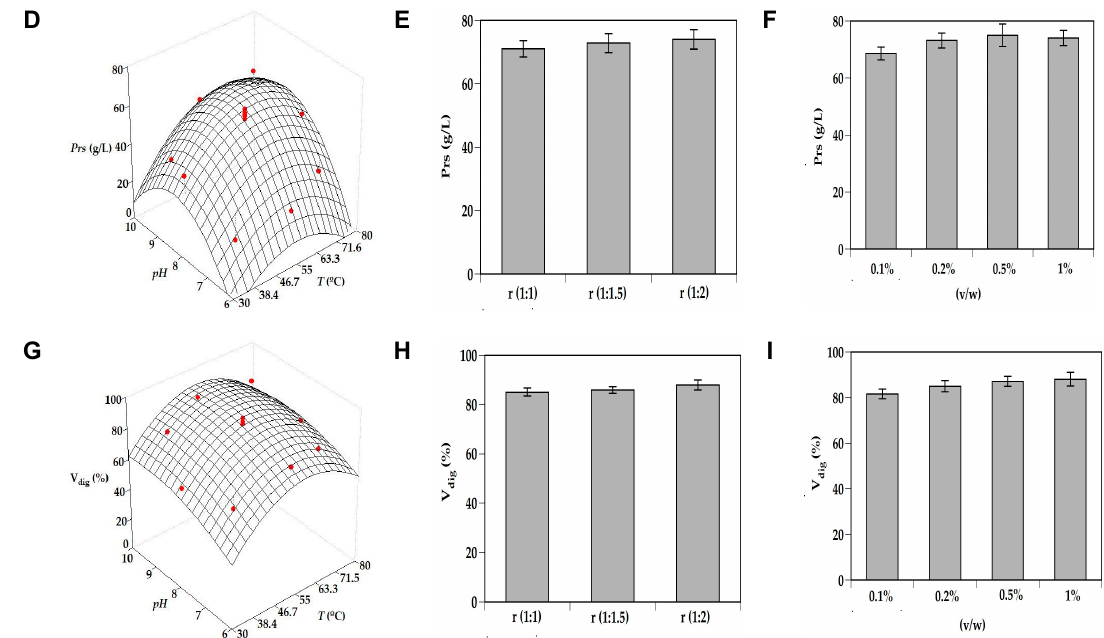
Figure 2. Optimization studies of heads-of-turbot (Tu_H) hydrolysis by Alcalase. Experimental data and predicted response surfaces describing the joint effect of pH and T on H m response ( A ), Prs response ( D ), and V dig response ( G ) as defined in Table 1. ( B ) Individual effect of S:L ratio on H m ; ( C ) individual effect of Alcalase concentration on H m ; ( E ) individual effect of S:L ratio on Prs; ( F ) individual effect of Alcalase concentration on Prs; ( H ) individual effect of S:L ratio on V dig ; ( I ) individual effect of Alcalase concentration on V dig . Error bars are the intervals of confidence for n = 2 (replicates of different hydrolysates) and α = 0.05.